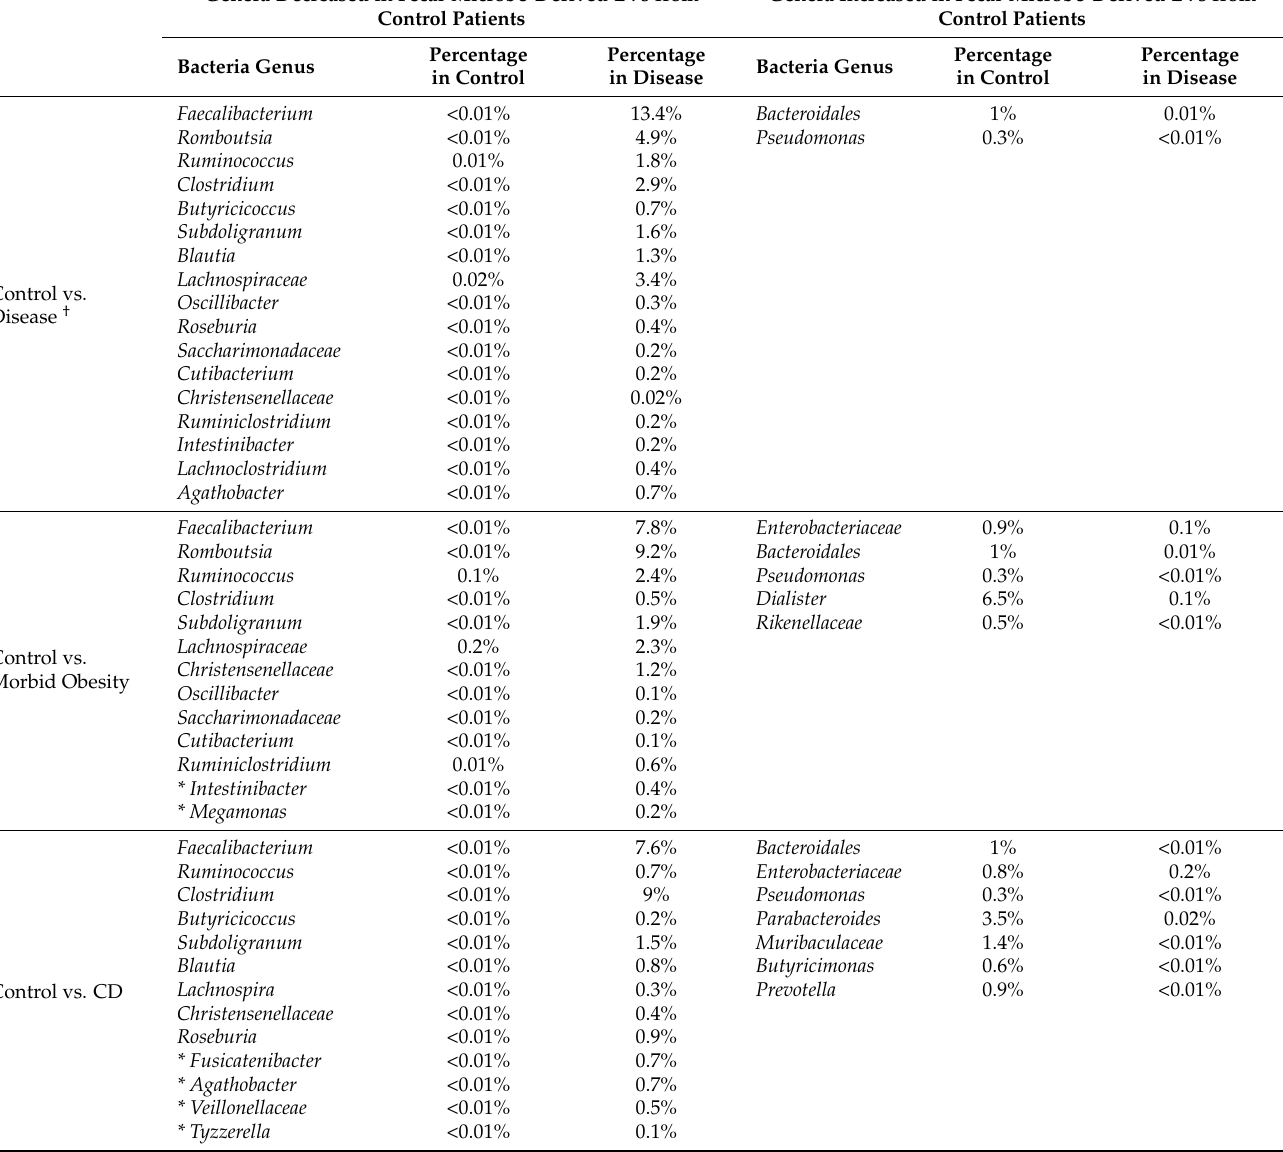
Table 1. Comparisons between the composition of fecal-microbe-derived EVs from different diseases. Only those genera with significant differences are shown ( p < 0.05). The percentage of each bacterial genus is shown in parentheses. † Disease groups included morbid obesity, Crohn’s disease (CD) and diarrhea groups. * Genus : genera that were exclusively increased or decreased in that disease when they were compared to the control group, and that were not significant in other diseases compared to the control